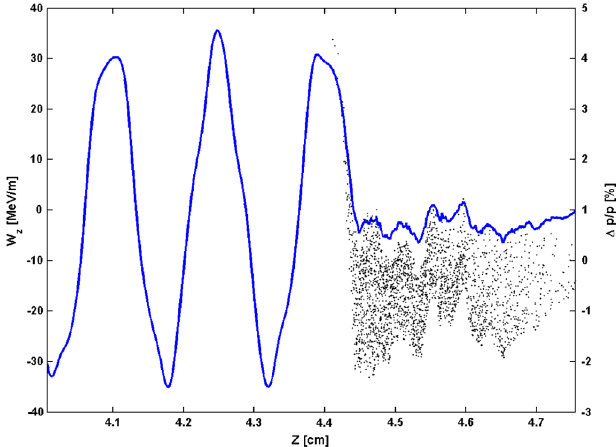
FIG. 10. BBU3000 simulation of the double-triangular bunch experiment. The bunch is passing through a dielectric structure, a ¼ 0 : 9 mm , b ¼ 0 : 75 mm , permittivity ¼ 3 : 75 . Points: longi- tudinal phase space (right ordinate); solid line: wake potential (left ordinate). The transformer ratio is (cid:1) 6 : 2